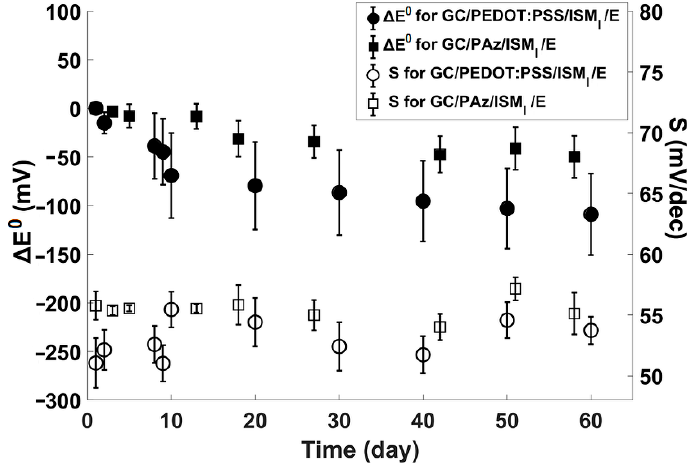
Figure 4. Comparison of Δ E 0 and sensitivity (S) long-term stability of biosensors with PEDOT:PSS and PAz solid-contacts.